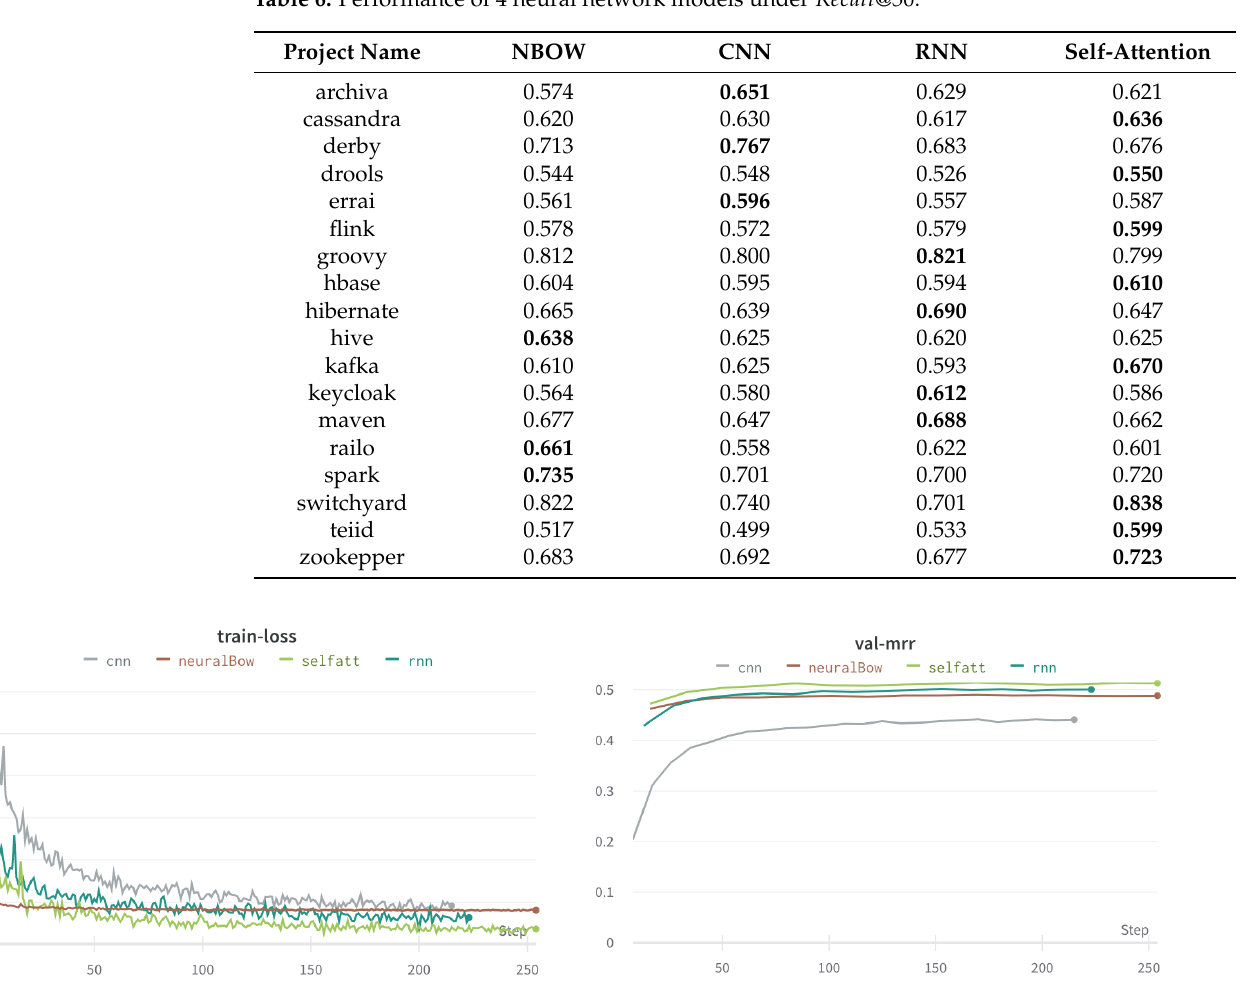
Table 6. Performance of 4 neural network models under Recall @50.